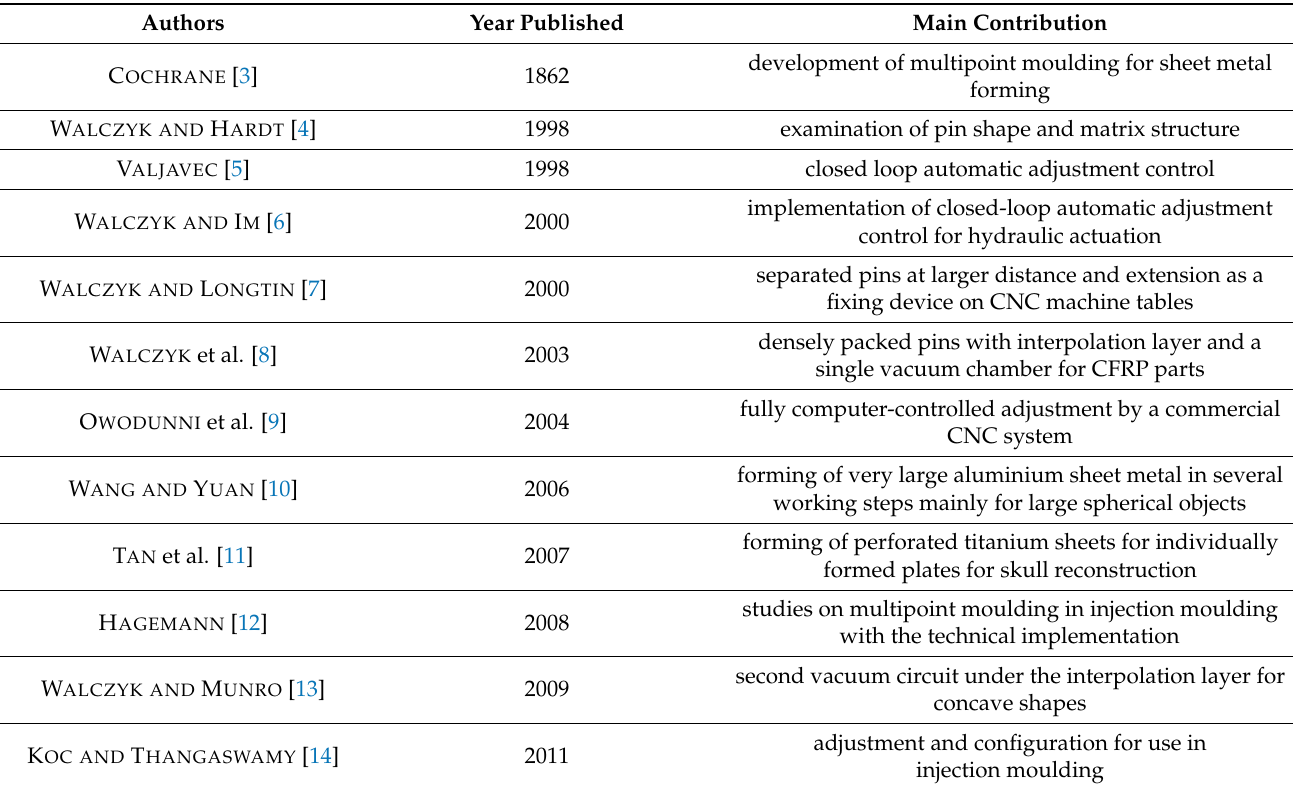
Figure 2. Schematic drawing of the first multipoint mould (based on the work in [3]). The further development of multipoint moulding with the main contribution of the authors is shown in Table 1 in a chronological order. Table 1. Chronological development of multipoint moulding.